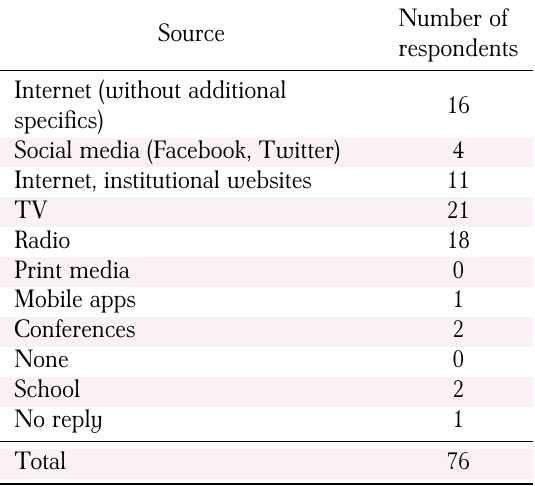
Table 4: Main sources of information on volcanic risk of re- spondents living in